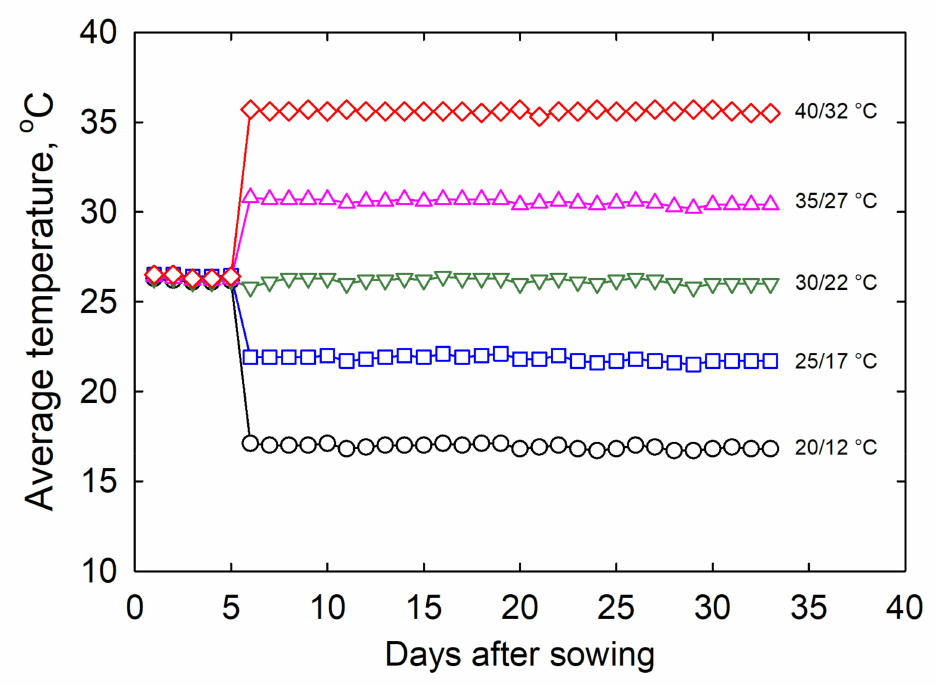
Figure 1. Average daily temperatures were recorded for five temperature treatments during the corn